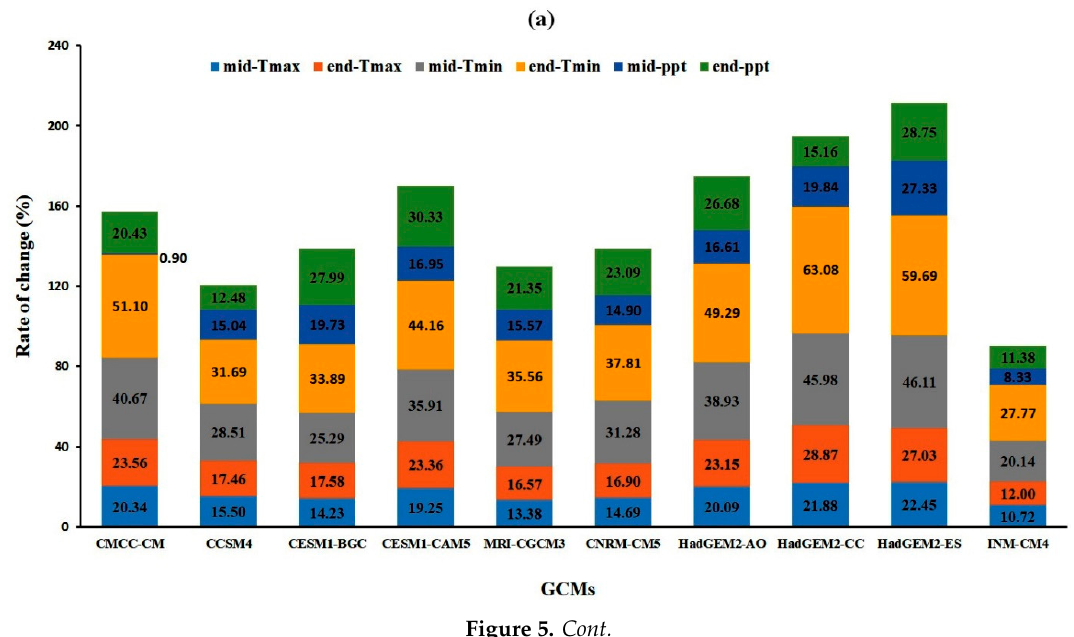
Figure 4. Average projected precipitation and temperature change for the 10 global climate models (GCMs) from baseline (1993–2018) for 2046–2065 mid-century (MC) and 2081–2099 end-century (EC) under the representative concentration pathways (RCP) 4.5 and RCP 8.5 scenarios.